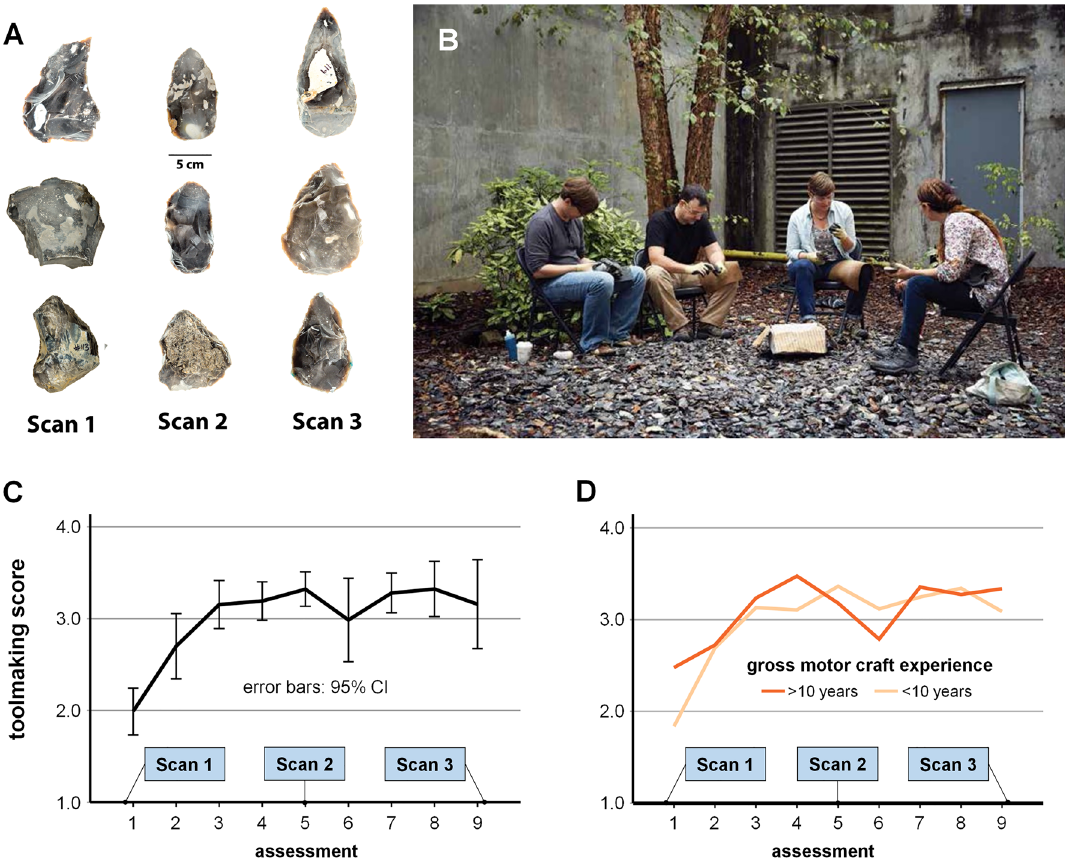
Figure 1. Participant artifacts and training. ( A ) Sample handaxes produced by participants for skill assessments at Scans 1, 2, and 3. ( B ) A practice session. Photo copyright Gregory Miller (gregorymillerpictures.com). ( C ) Learning curve in the whole trained group. ( D ) Learning curve separated by prior gross motor craft